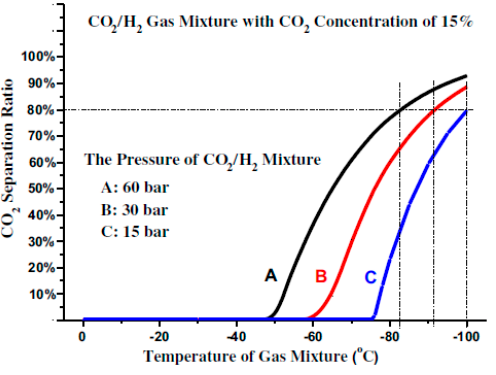
Figure 4. Variation in pressure and separation ratio of CO 2 /H 2 mixture with temperature at 15 mol % CO 2 concentration [8].